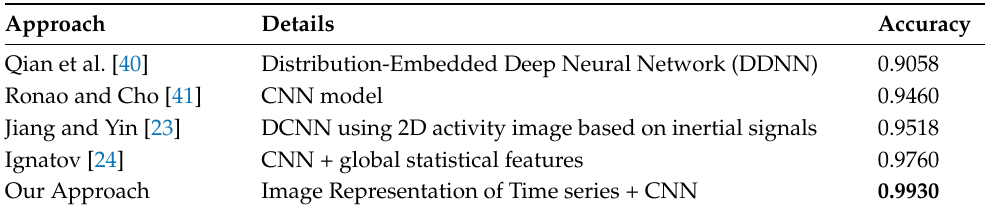
Table 3. Comparison considering UCI-HAR